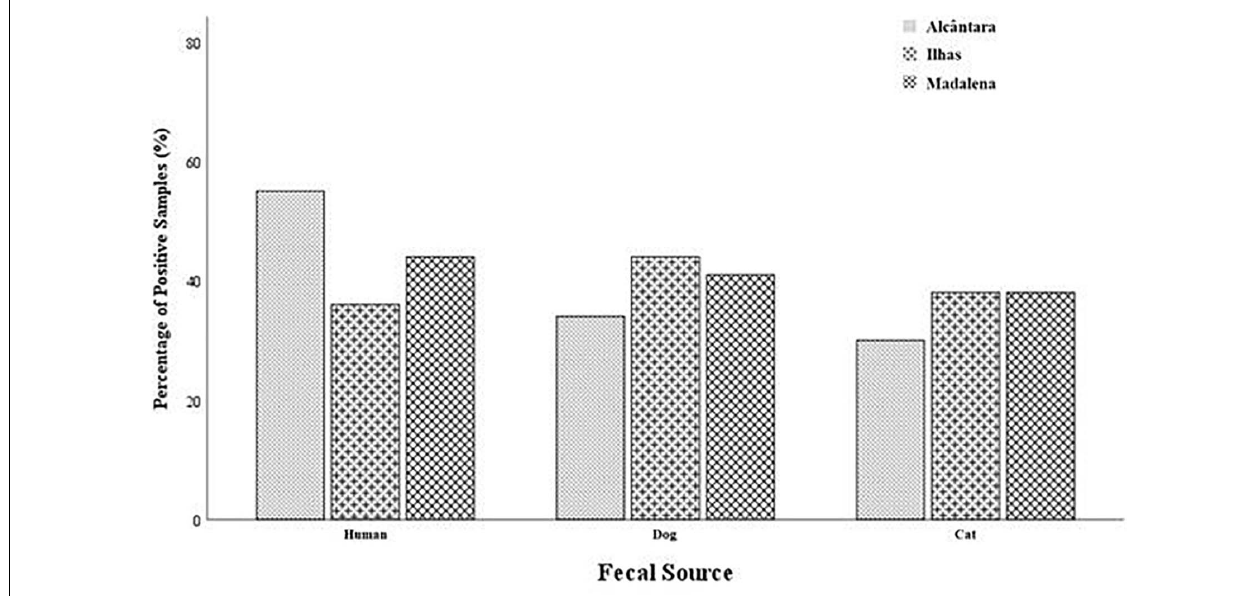
FIGURE 4 | Percentage of positive samples in each basin per source of fecal contamination.